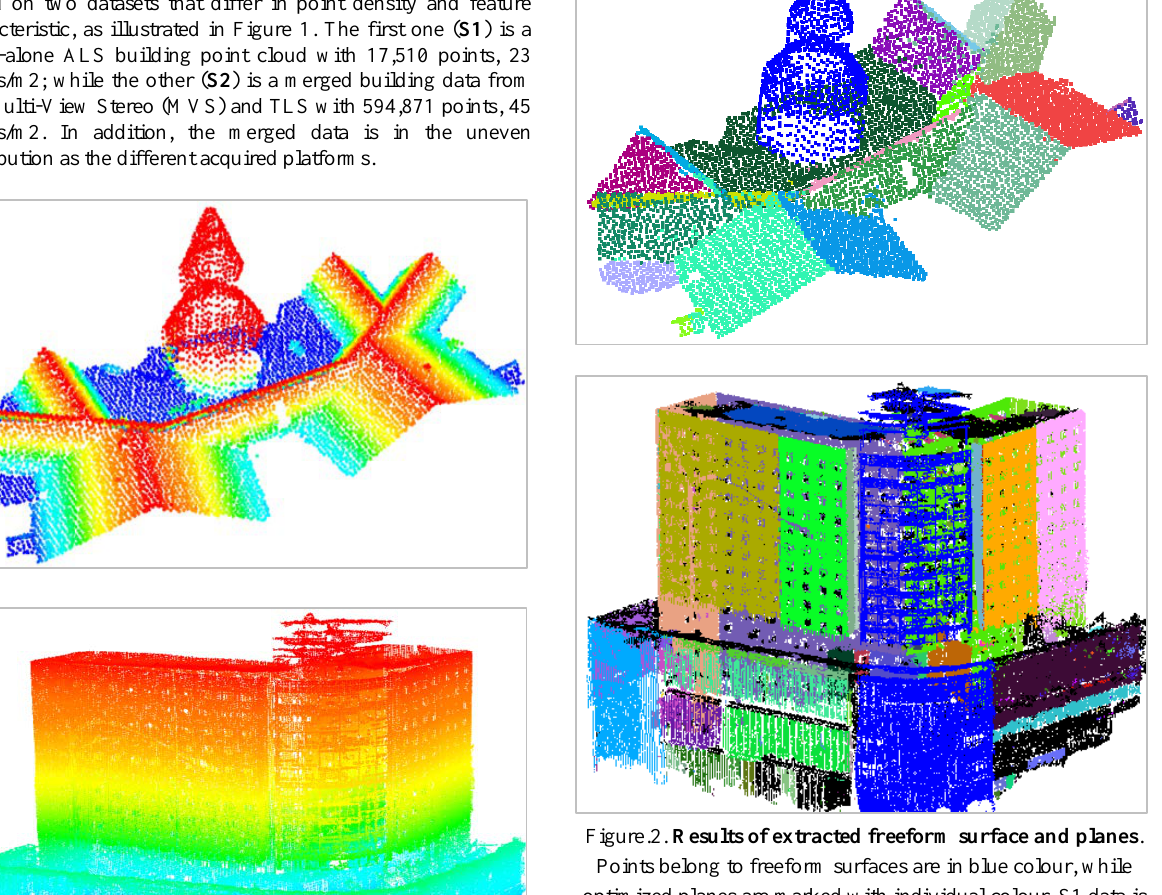
and parametric planes (colored blue). Each grouped irregular points are reconstructed as meshes by Poisson surface reconstruction. In additional, compact hybrid models are linked by the interpolation between vertexes of meshes and